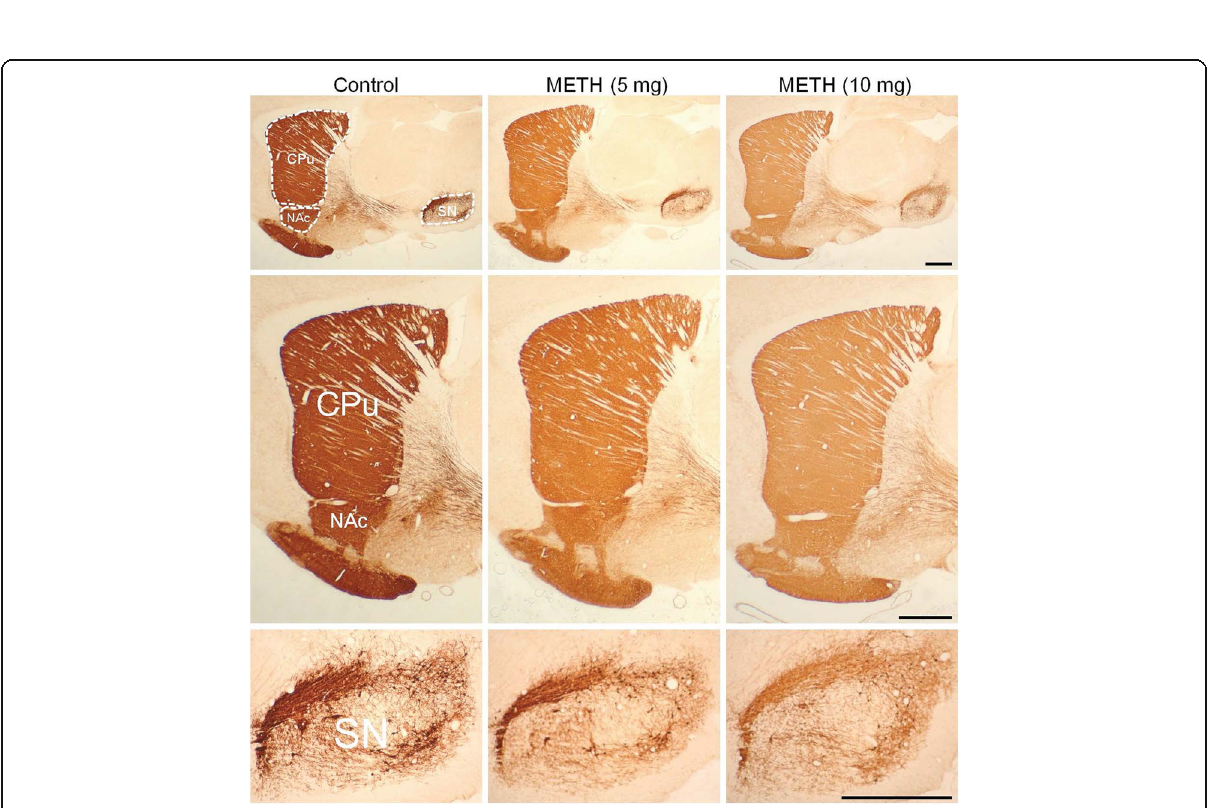
Fig. 5 Immunohistochemical photomicrographs of tyrosine hydroxylase (TH) immunoreactivity at the para-sagittal levels of the control and METH-induced brains (upper panel) and their magnifications (middle and lower panels). CPu, striatum; NAc, nucleus accumbens; SN, substantia